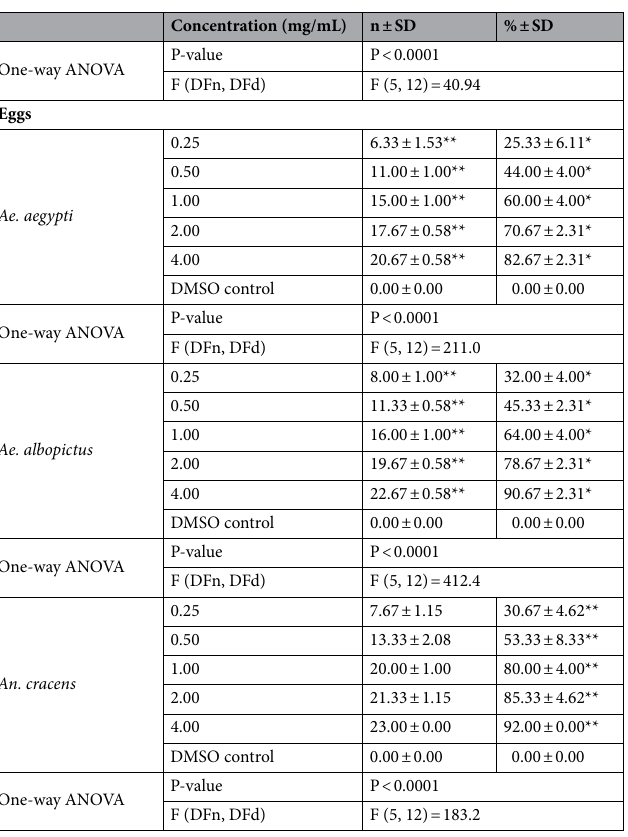
Table 1. Mean mortalities of Ae. aegypti (larvae, adults and eggs), Ae. albopictus (larvae, adults and eggs), An, cracens (larvae, adults and eggs), and Cx. quinquefasciatus (larvae only) on different concentrations of Streptomyces sp. KSF103 EA extract. Negative control–nil mortality, a mean value of three replicates, * significant at P < 0.05 level, ** significant at P < 0.0001